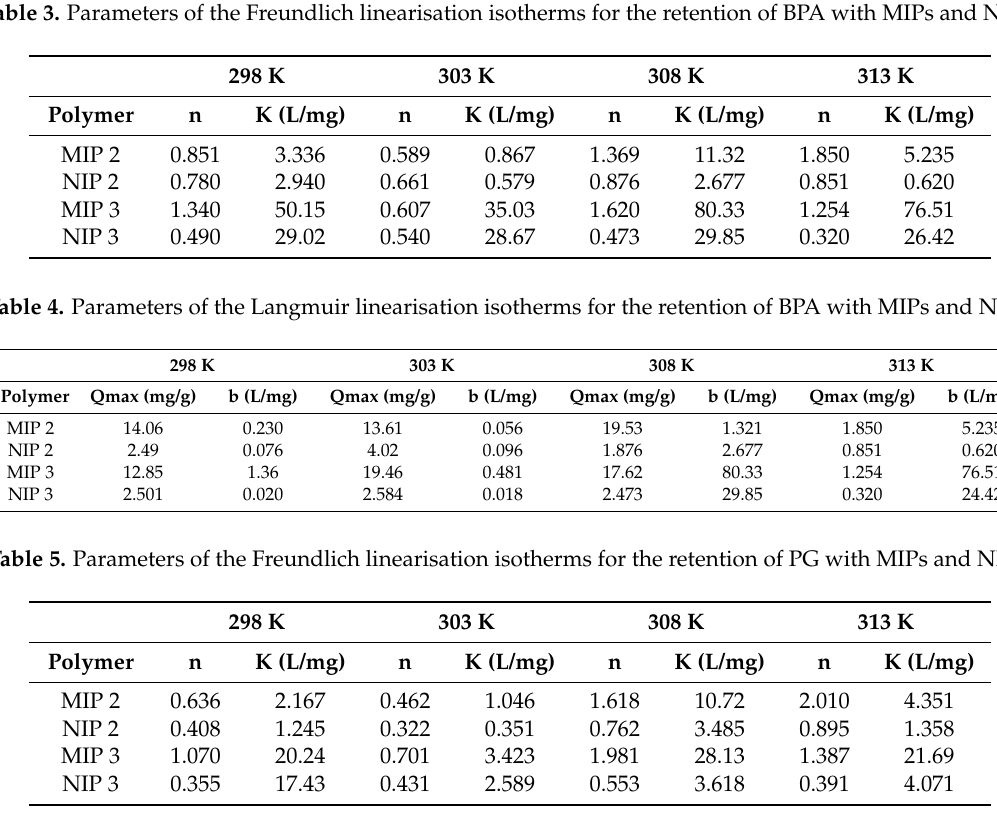
Table 6. Parameters of the Langmuir linearisation isotherms for the retention of PG with MIPs and NIPs. 298 K 303 K 308 K 313